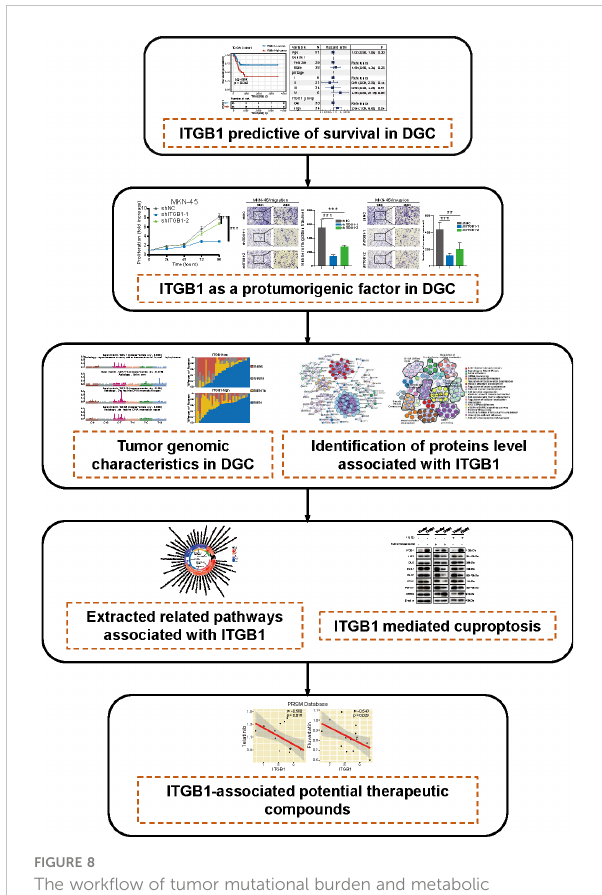
FIGURE 8 The work fl ow of tumor mutational burden and metabolic characteristics associated with ITGB1 in